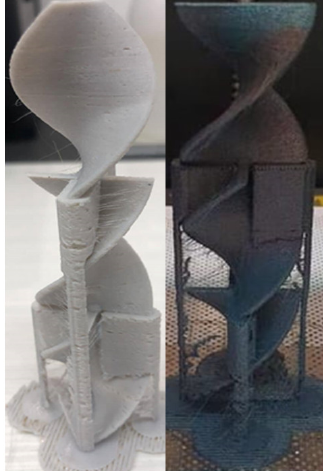
Figure 18. Three-dimensional-printed static mixers made of composites PET-G 6T 0C ( left ) and PET-G 1.5T 0.5C ( right ) before the removal of the support structures .